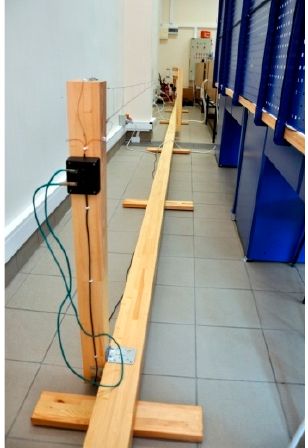
Figure 5. Model of two spans of electric traction.